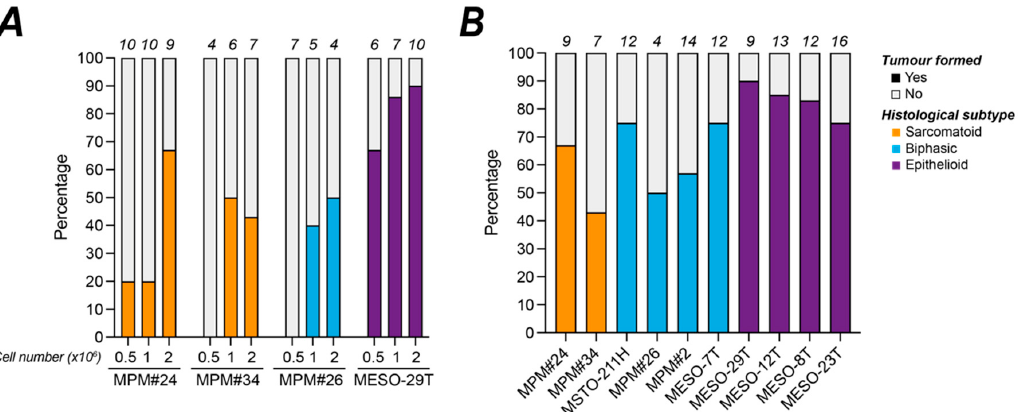
Figure 3. Efficiency of MPM cell line engraftment on the CAM. ( A & B ) Stacked histograms show the percentage of viable eggs at E14 where tumour nodules had engrafted. ( A ) Experimental determination of the optimal cell number for im plantation on the CAM for 4 cell lines; ( B ) Engraftment efficiency for the 10 MPM cell lines implanted with 2 million cells; supporting survival data in Table S1. The number of viable engrafted eggs at E14 for each cell line is shown above the bars on each graph. All experiments were in ovo .